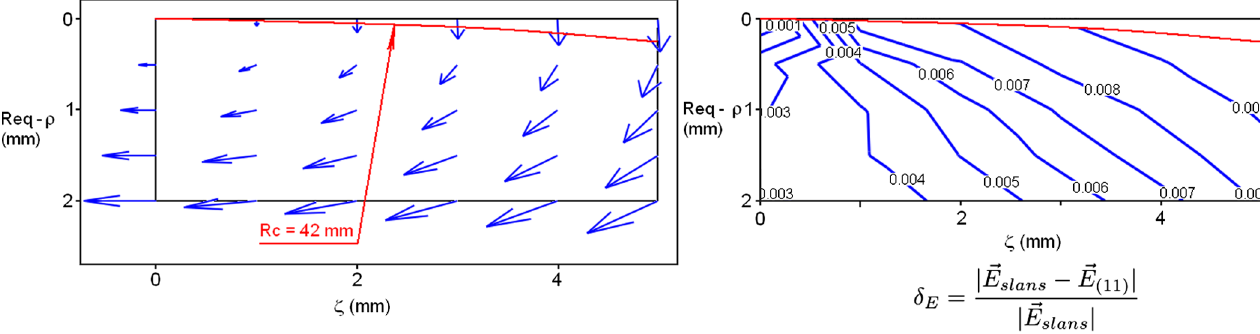
(11).FIG. 4. Left: Electric field in the TESLA cavity near the equator. Vectors outside the cavity volume are formal extrapolation with formula (11). Right: Difference between results calculated with SLANS and with formula